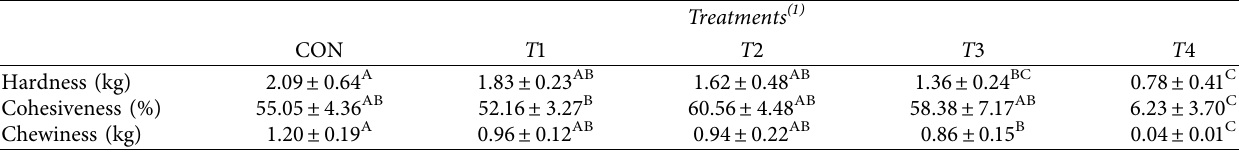
Table 5: Texture profle analysis of the hybrid beef patty with shiitake mushroom ( Lentinus edodes